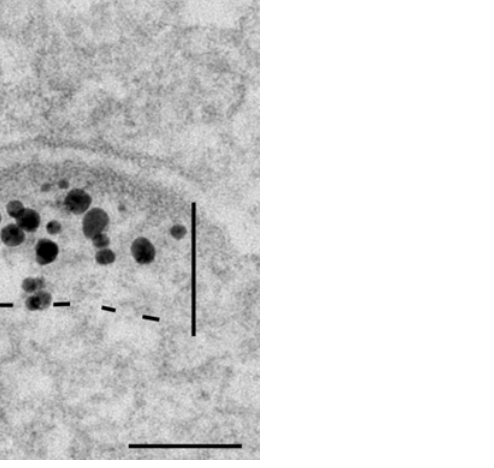
Fig 1. Electron micrograph of an asymmetric synapse from dissociated hippocampal culture labeled for Shank3 with ab2. Labeling intensity at the PSD is measured by counting all particles within the marked area 120 nm below the postsynaptic membrane, divided by the length of the PSD, and expressed as number of labels/ μ m PSD. Distance of label from the postsynaptic membrane is measured from the center of the particle to the outer edge of the membrane (white arrow). Scale bar = 0.1 μ